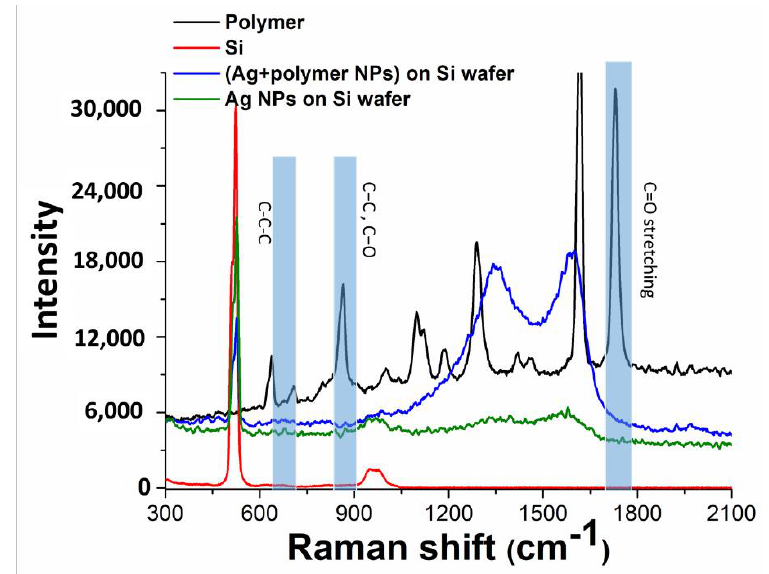
Figure 5. Raman spectra of samples: donor PET and acceptor Si substrates, Ag NPs transferred onto acceptor Si substrates from the donor PET and glass substrates.